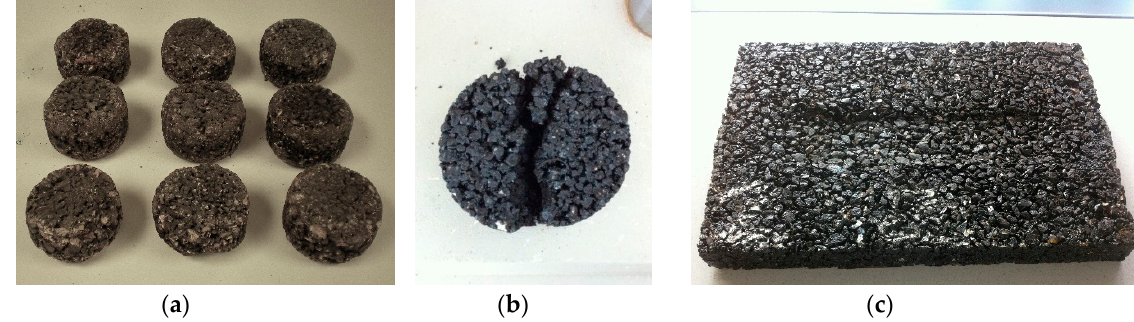
Figure 8. Mixture durability.